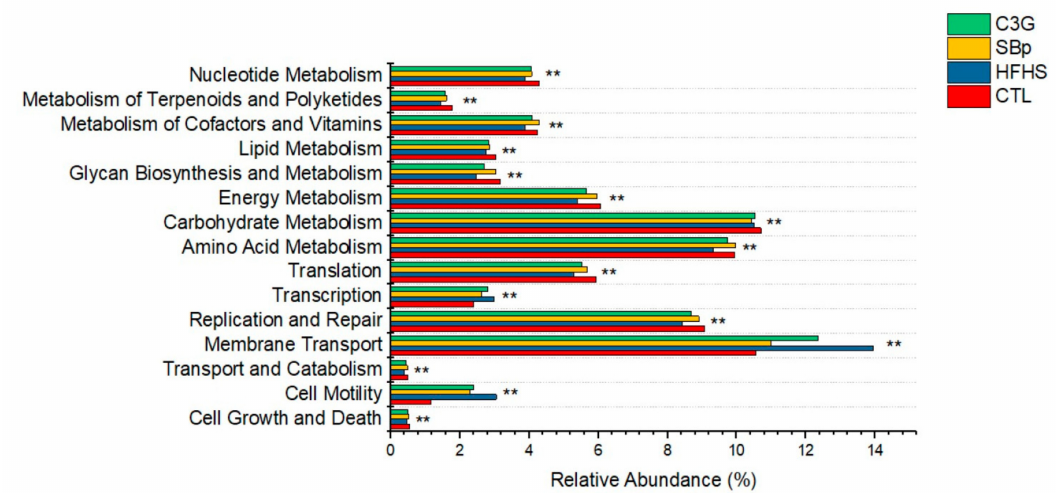
Figure 8. E ff ects of HFHS diets supplemented with and without C3G on metagenome functional activity in gut microbiota based on the Phylogenetic Investigation of Communities by Reconstruction of Unobserved States (PICRUSt). The experimental regimen was the same as described in legend of Figure 1. Di ff erences in relative abundance (%) in each selected pathway among various dietary groups are in the form of a bar plot. Values are expressed as mean value ( n = 8 / group). **: p < 0.01, showing ANOVA results among the four